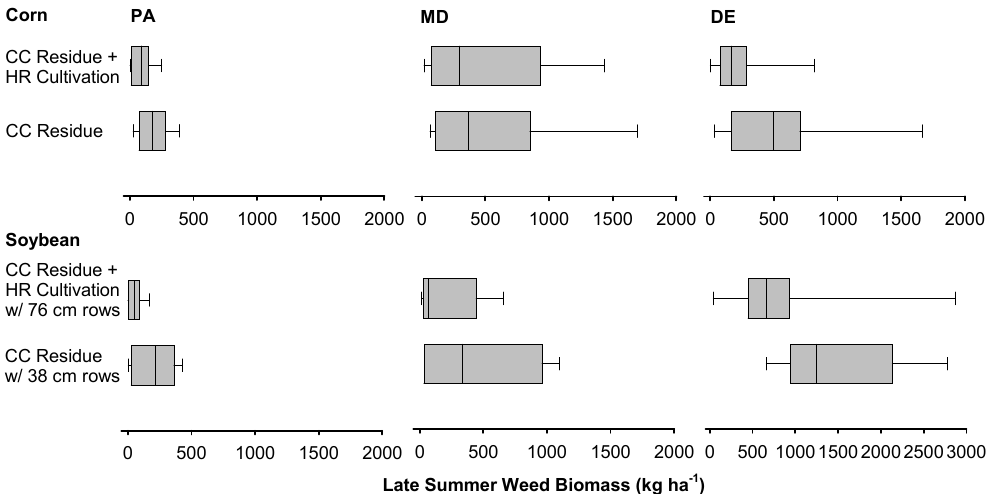
Figure 4. Effect of rolled cover crop (CC) surface residue on weed biomass with or without the use of high ‐ residue (HR) inter ‐ row cultivation; data from the Reduced ‐ tillage Organic Systems Experiment (ROSE). In Pennsylvania (PA), HR cultivation in no ‐ till corn decreased weed abundance ( F 1,55 = 8.1, p = 0.006). In Delaware (DE, F 1,55 = 13.7, p < 0.001) and Maryland (MD, F 1,55 = 3.7, p = 0.05), HR cultivation in no ‐ till soybean decreased weed abundance compared to when soybean was planted on 38 ‐ cm rows in the absence of HR cultivation, which was evaluated as an alternative weed control strategy.